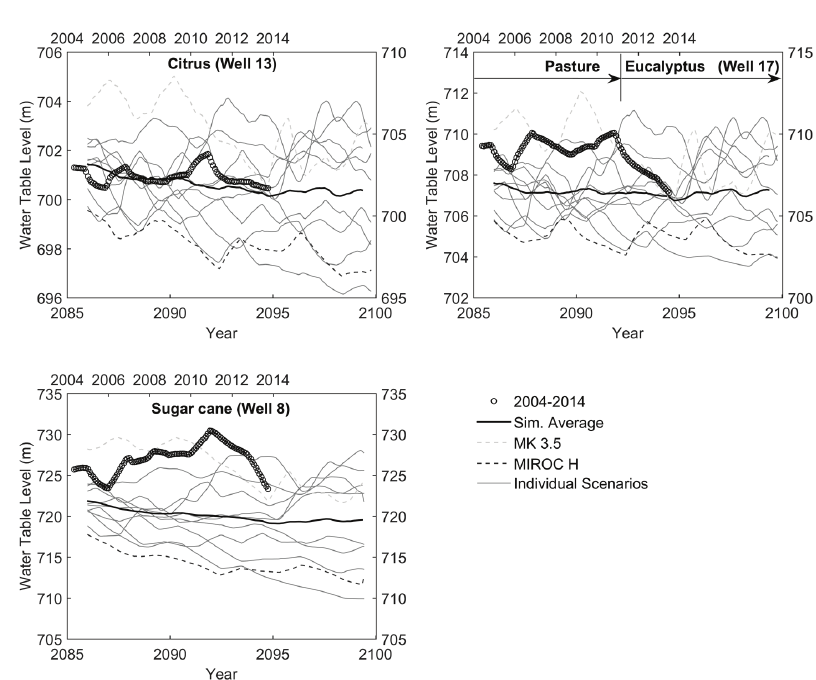
Figure 10 - Moving average of observed (circles) and simulated (lines) hydrographs in three wells for the 2004-2014 land use. The land use around well 17 has changed from pasture to eucalyptus in 2011.